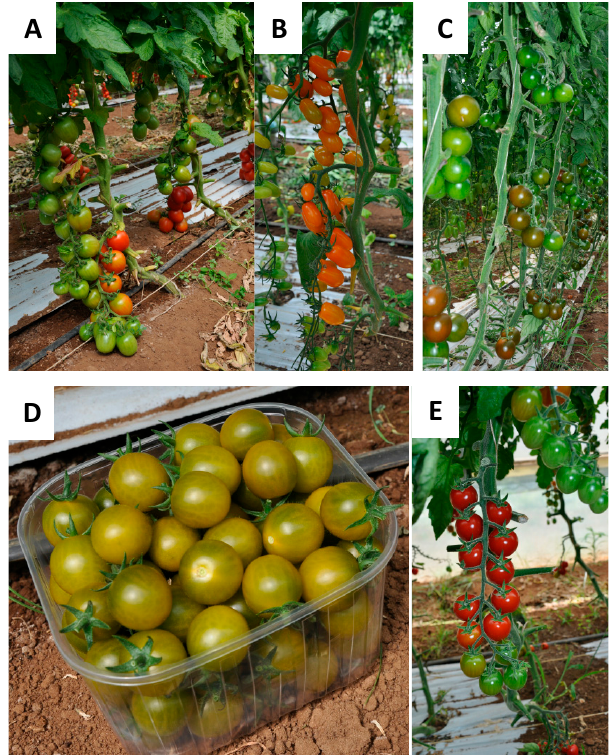
Figure 1. Tomato cultivars from Fondi area (Lazio region): ( A ) Fiaschetta di Fondi; ( B ) Bamano; ( C ) King Creole; ( D ) DulceMiel; ( E ) Sugarland.